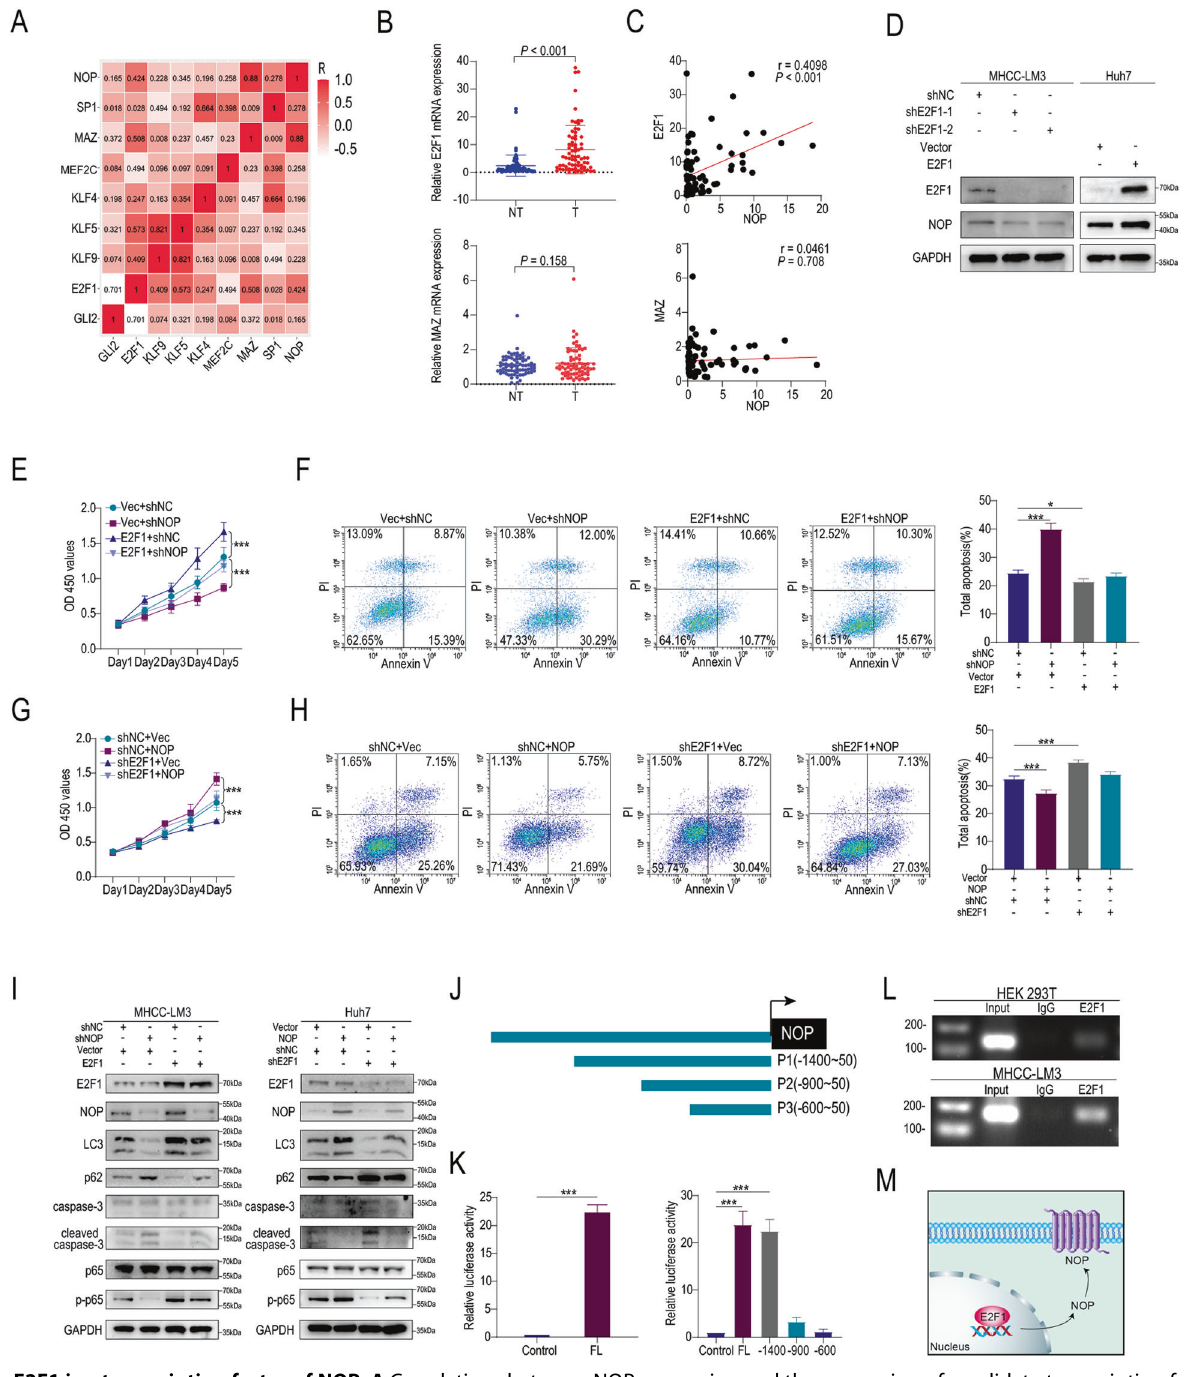
Fig. 5 E2F1 is a transcription factor of NOP. A Correlations between NOP expression and the expression of candidate transcription factors. B Expression of E2F1 and MAZ in HCC and adjacent tissues. C Correlation between NOP expression and E2F1 or MAZ expression. D IB analysis of the indicated proteins in MHCC-LM3 and Huh7 cells. E CCK-8 assay showing the proliferation of vector + shNC, vector + shNOP, E2F1 + shNC, and E2F1-shNOP HCC cells. F Apoptosis rates in vector + shNC, vector + shNOP, E2F1 + shNC, and E2F1-shNOP HCC cells. G CCK-8 assay showing the proliferation of shNC + vector, shNC + NOP, shE2F1 + vector, and shE2F1 + shNOP HCC cells. H Apoptosis rates in shNC + vector, shNC + NOP, shE2F1 + vector, and shE2F1 + shNOP HCC cells. I IB analysis of the indicated proteins associated with autophagy and apoptosis in MHCC-LM3 and Huh7 cells. J Schematic drawing of the full-length and truncated NOP fragments. K Luciferase assay showing the binding site of NOP and E2F1. L. A speci fi c band of the expected size was detected in the input DNA and the anti-E2F1 antibody (anti-E2F1)-precipitated DNA by ChIP. M Schematic showing the effect of increased expression of NOP via the transcription factor E2F1. *** P < 0.001, * P < 0.05.